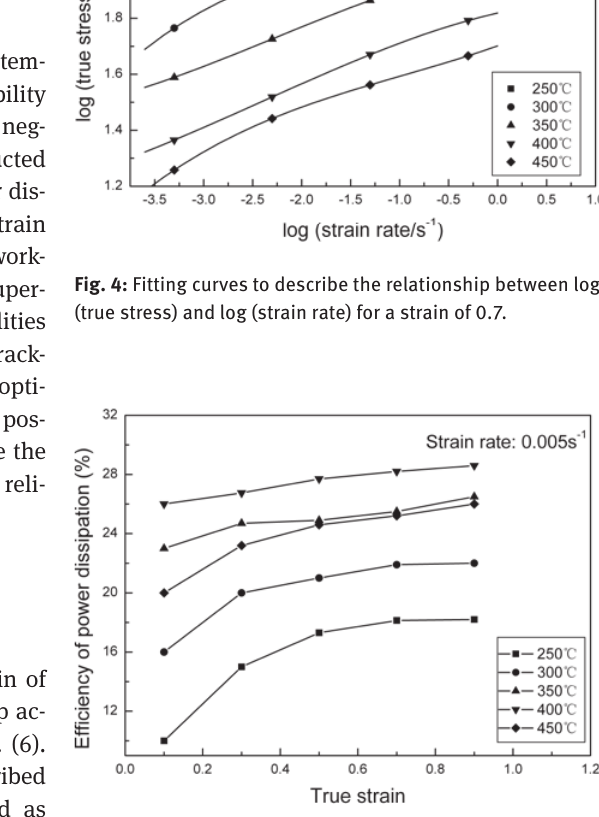
Fig. 5: Variation of the efficiency of power dissipation of 7005 alloy with strain at a strain rate of 0.005 s − 1